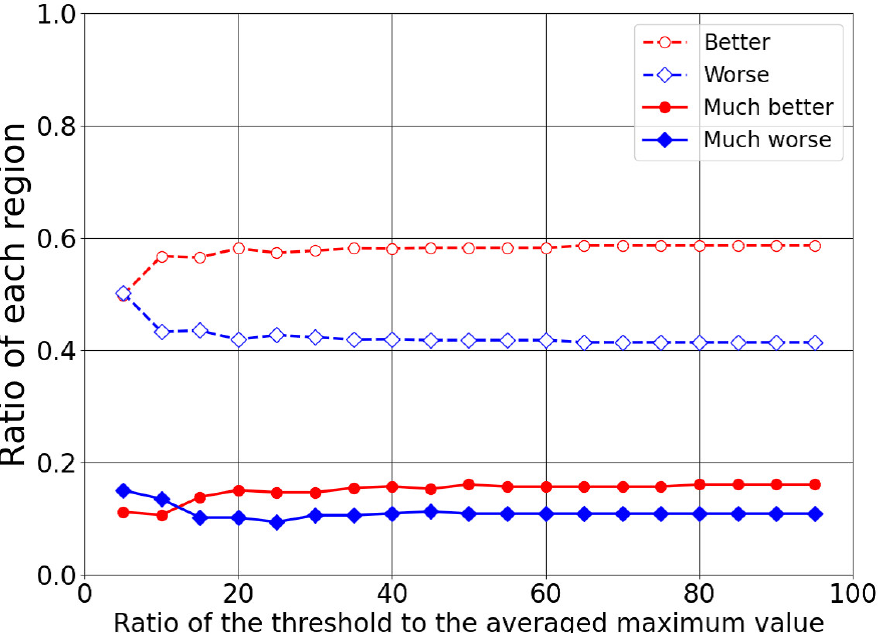
Figure 13. Impact of the ratio of the thresholds to the averaged maximum values in Table 4 on the the